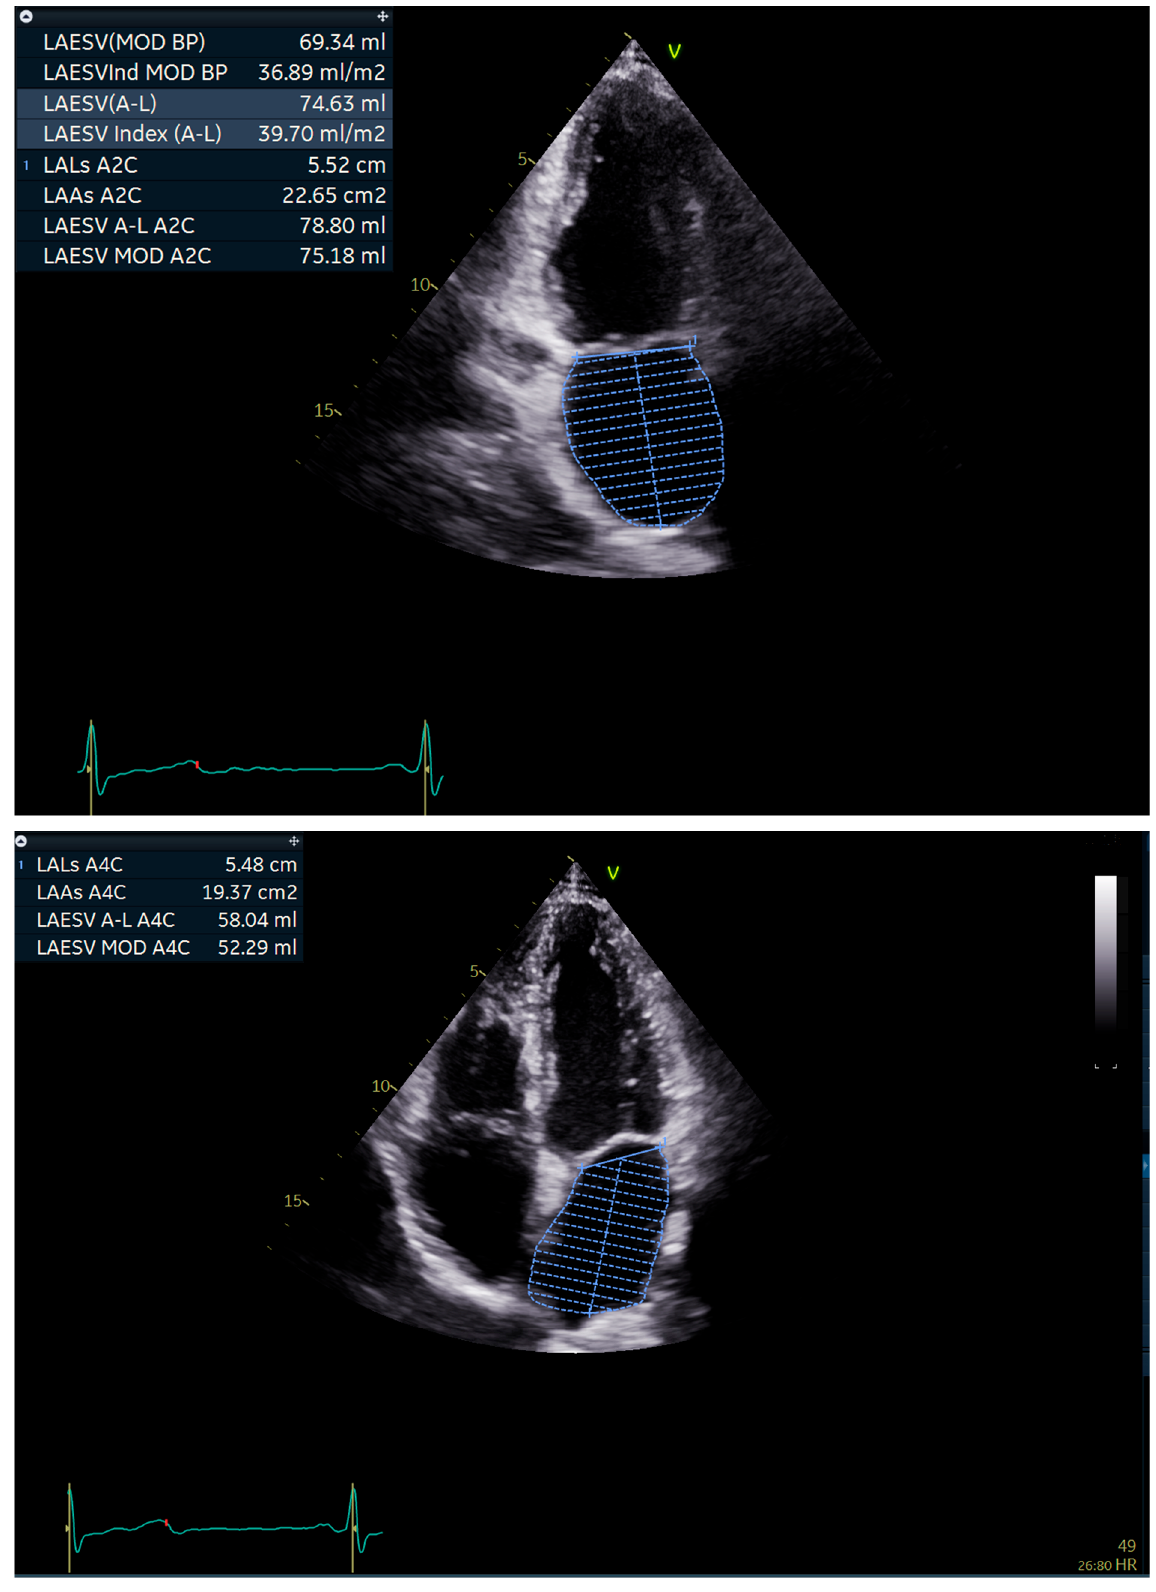
Figure 1. 2 Chamber and 4 Chamber apical views with measurements performed at end-systole. Linear measurements were obtained exclusively using 2D. Anterior–posterior meas- urements were performed in the parasternal long axis (PLAX) and surfaces measured in